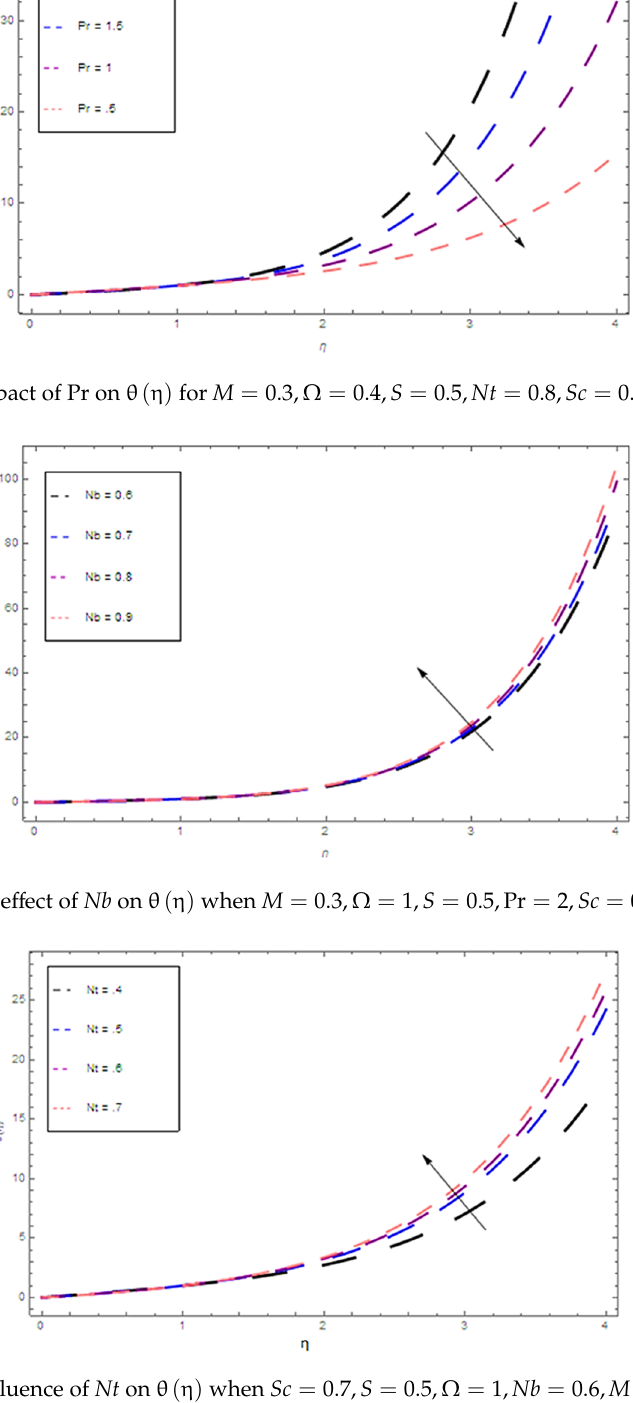
Figure 12. The influence of Nt on     . Figure 12. The influence of Nt on θ ( η ) when Sc = 0.7, S = 0.5, Ω = 1, Nb = 0.6, M = 0.3,Pr = Figure 12. The influence of Nt on Figure 12. The influence of Nt on